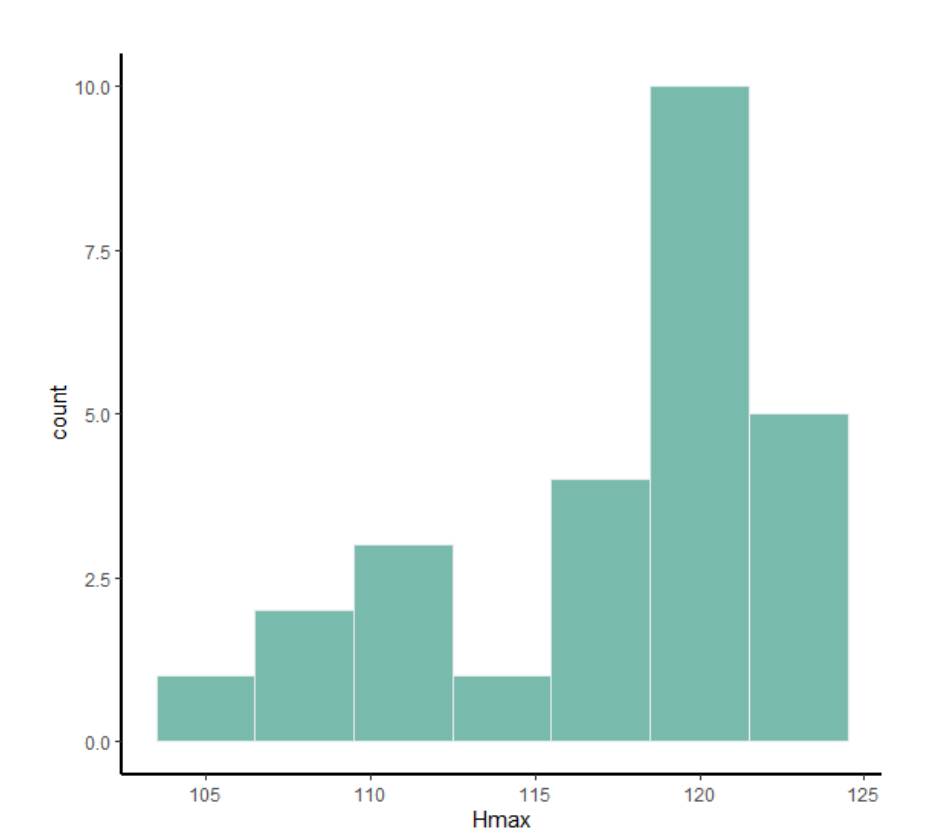
Figure 4. Frequency distribution of the maximum height (Hmax) in the calcaneum of S. etruscus .